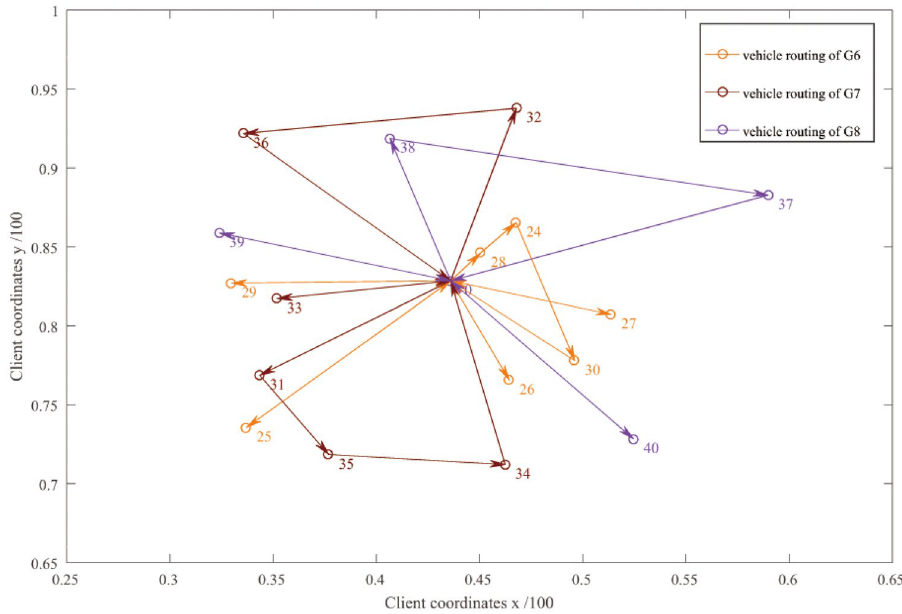
Figure 5. Distribution route optimization of vehicle for HSR G6, G7, G8.